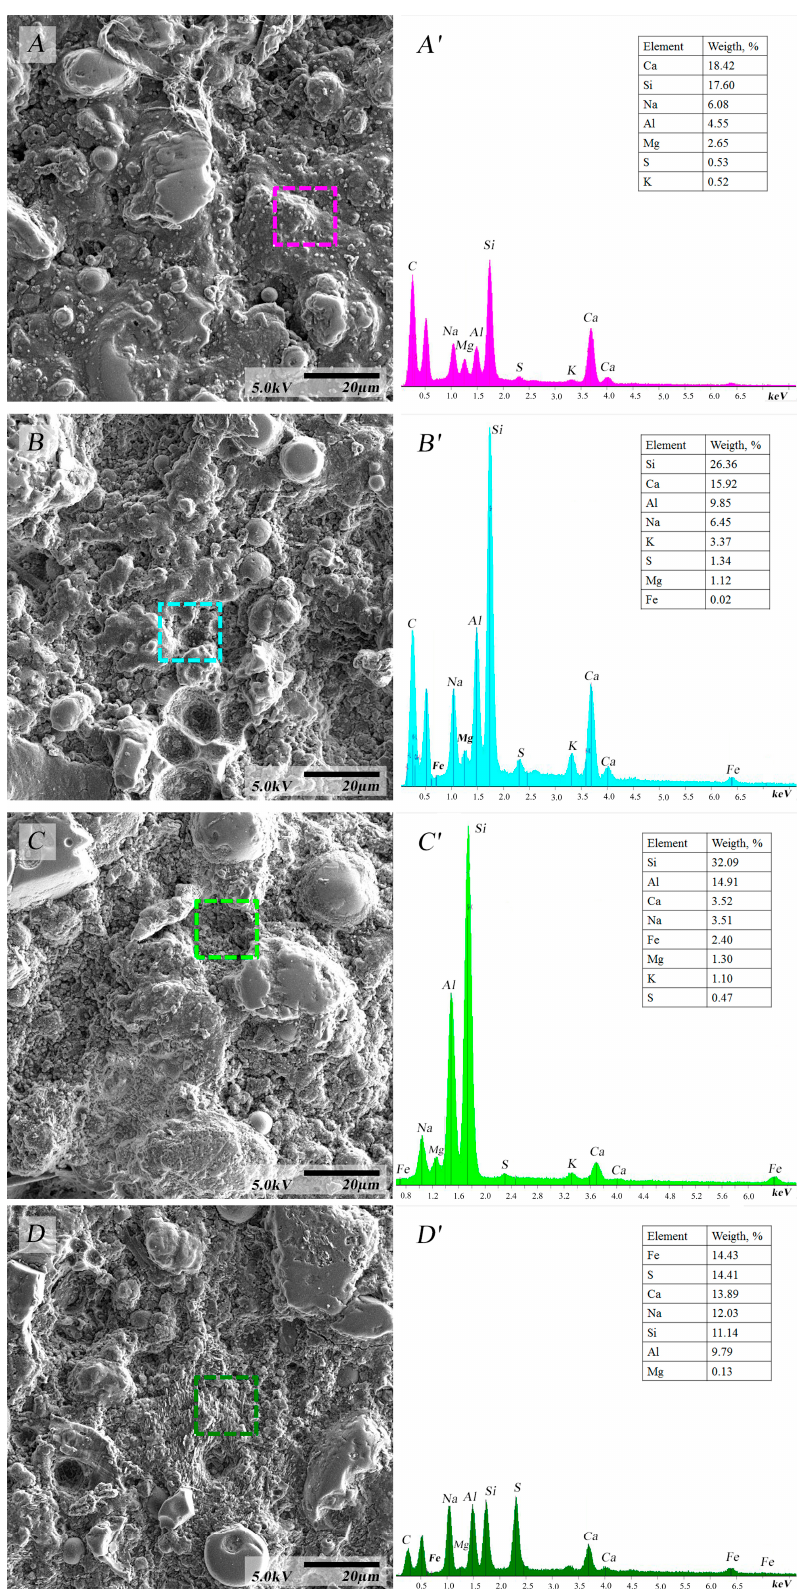
Figure 7. SEM micrographs and the corresponding EDS spectra of the raw and milled fly-ash-based geopolymers after 28 days of curing. ( A , A’ ) Raw. ( B , B’ ) Ball-milled 30 min. ( C , C’ ) Ball-milled 60 min. ( D , D’ ) A tt rition-milled.